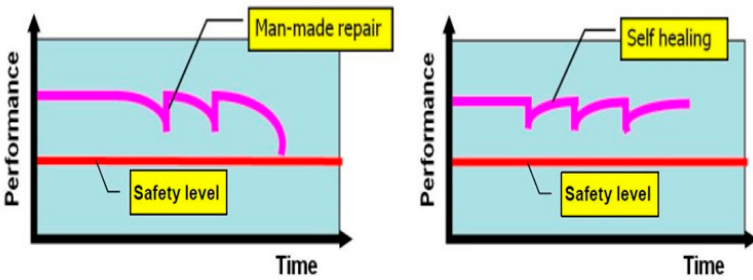
Figure 1. Damage Prevention Paradigm (DPP)—Manual Repair (left) and Damage Control Paradigm (DCP)—Self Regeneration (right) [5].